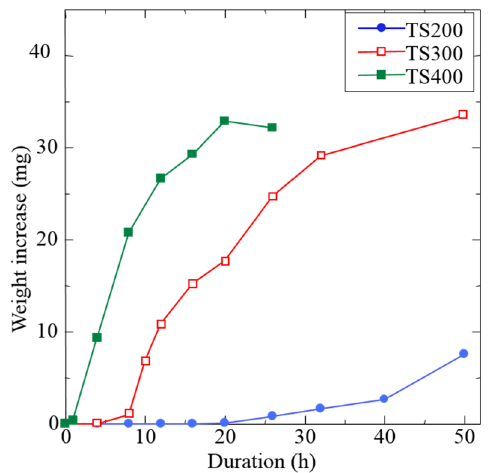
Figure 4. SEM images for cross ‐ section of Ti samples prepared by mechanical coating at 400 rpm after